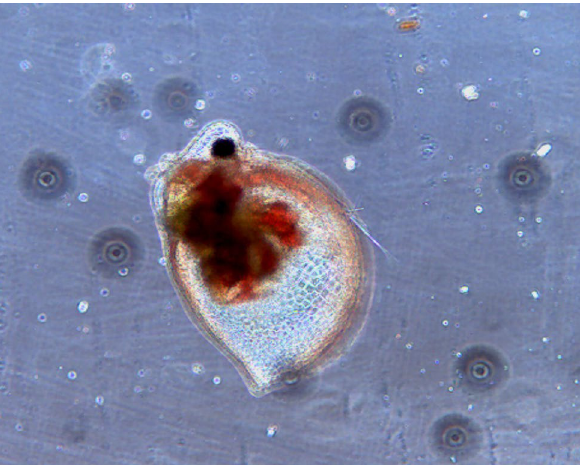
Fig. 1 Microscopic view (100×) of Ceriodaphnia spp. present in